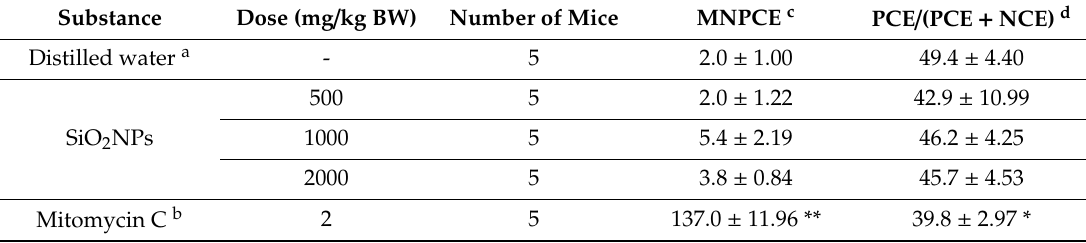
Table 4. Micronucleated polychromatic erythrocytes in mice bone marrow following treatment with SiO 2 NPs.